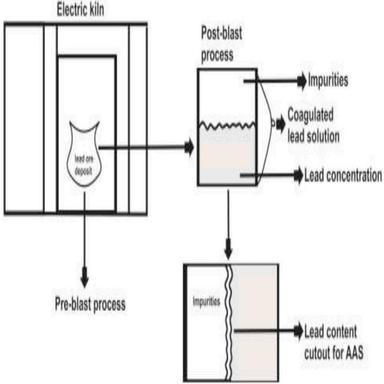
The firing process.